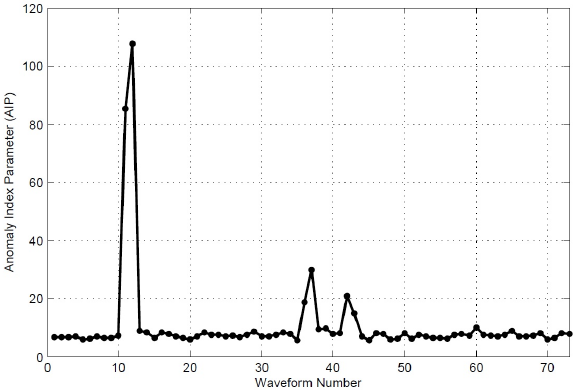
Figure 3. Anomaly Index Parameter (AIP) along the analyzed CryoSat-2 track segment (73 waveforms) in the study area.